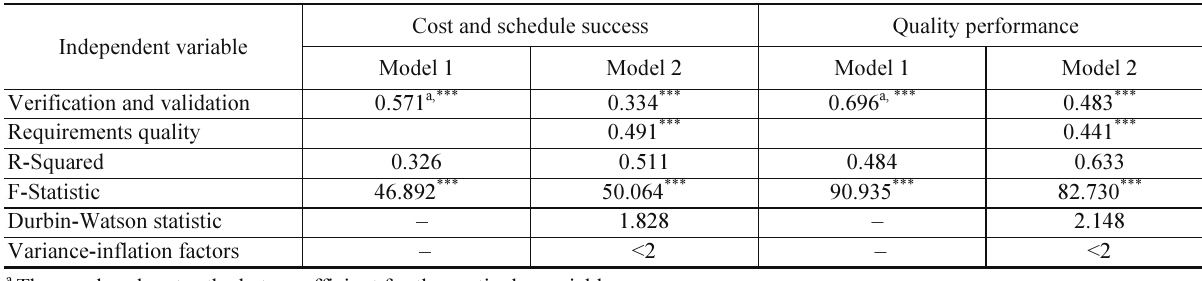
Table 4 . Mediator between requirements verification and validation and project performance Independent variable